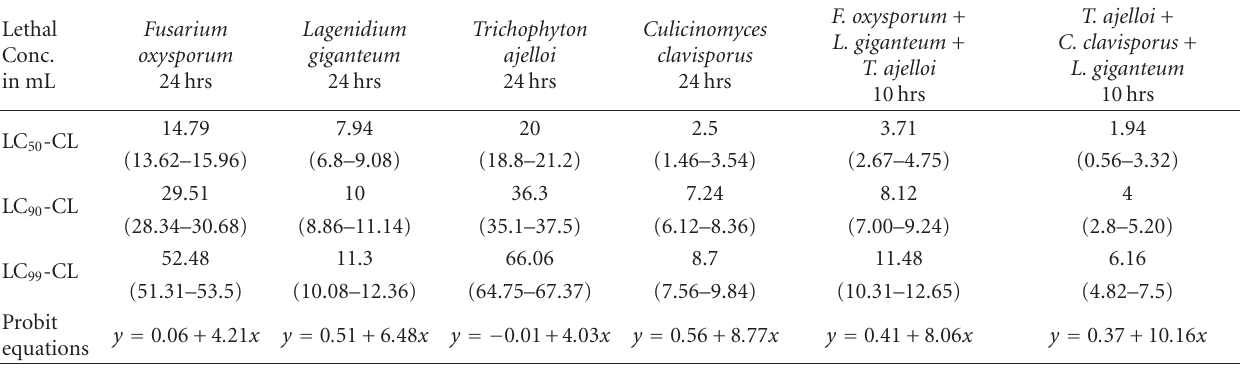
Table 1: The lethal concentration (LC) in mL of T. ajelloi metabolites on C. quinquefasciatus with their confidential limits (CL) values with their probit